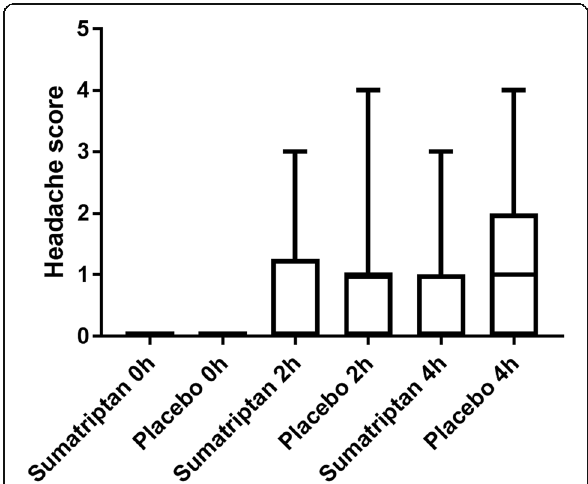
Fig. 2 Headache score after treatment. Headache score 0 h, 2 h and 4 h after treatment with placebo and sumatriptan. There was no difference in headache score at any time-point between the two treatment days